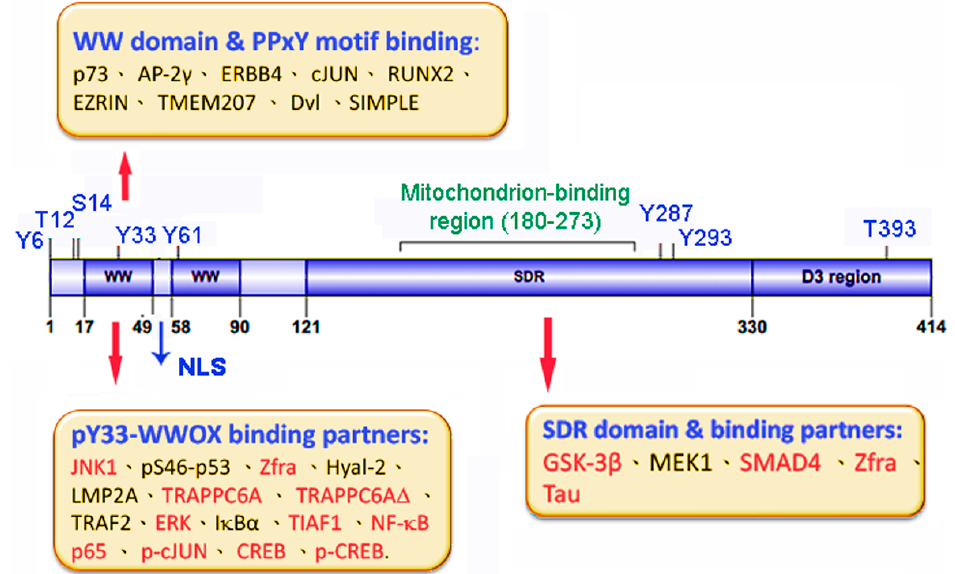
Figure 1. WWOX physically binds proteins via the N -terminal first WW domain and the C -terminal SDR domain. Upon phosphorylation at Tyr33, pY33-WWOX acquires a significant increase in the numbers of binding partners. Phosphorylation sites at Ser14, Tyr33, and Tyr287 have been documented [52–54]. Other phosphorylation sites need further investigation. See legends in the text for details. NLS = nuclear localization signal (KRKR).